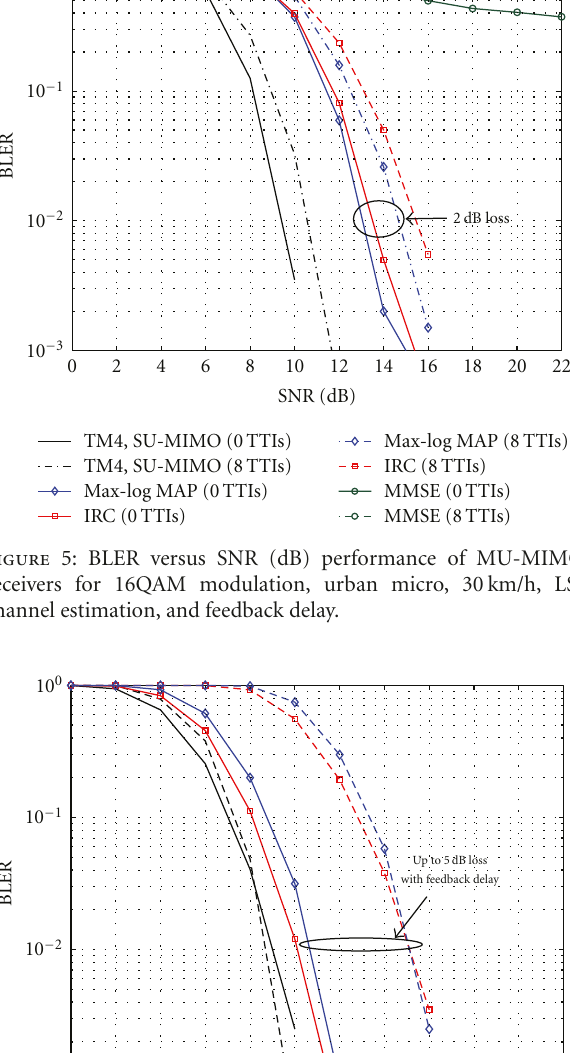
From the cumulative distribution function of the user throughput, it is observed that the 95% ile (peak) user throughput of the MU-MIMO system is lower than that of the SU-MIMO system. At the 5% ile (cell edge) user throughput there is no di ff erence in the performance of MU-MIMO system and SU-MIMO system. This behavior comes from the fact that in the MU-MIMO PS we try not to schedule cell-edge UEs in MU-MIMO mode Section